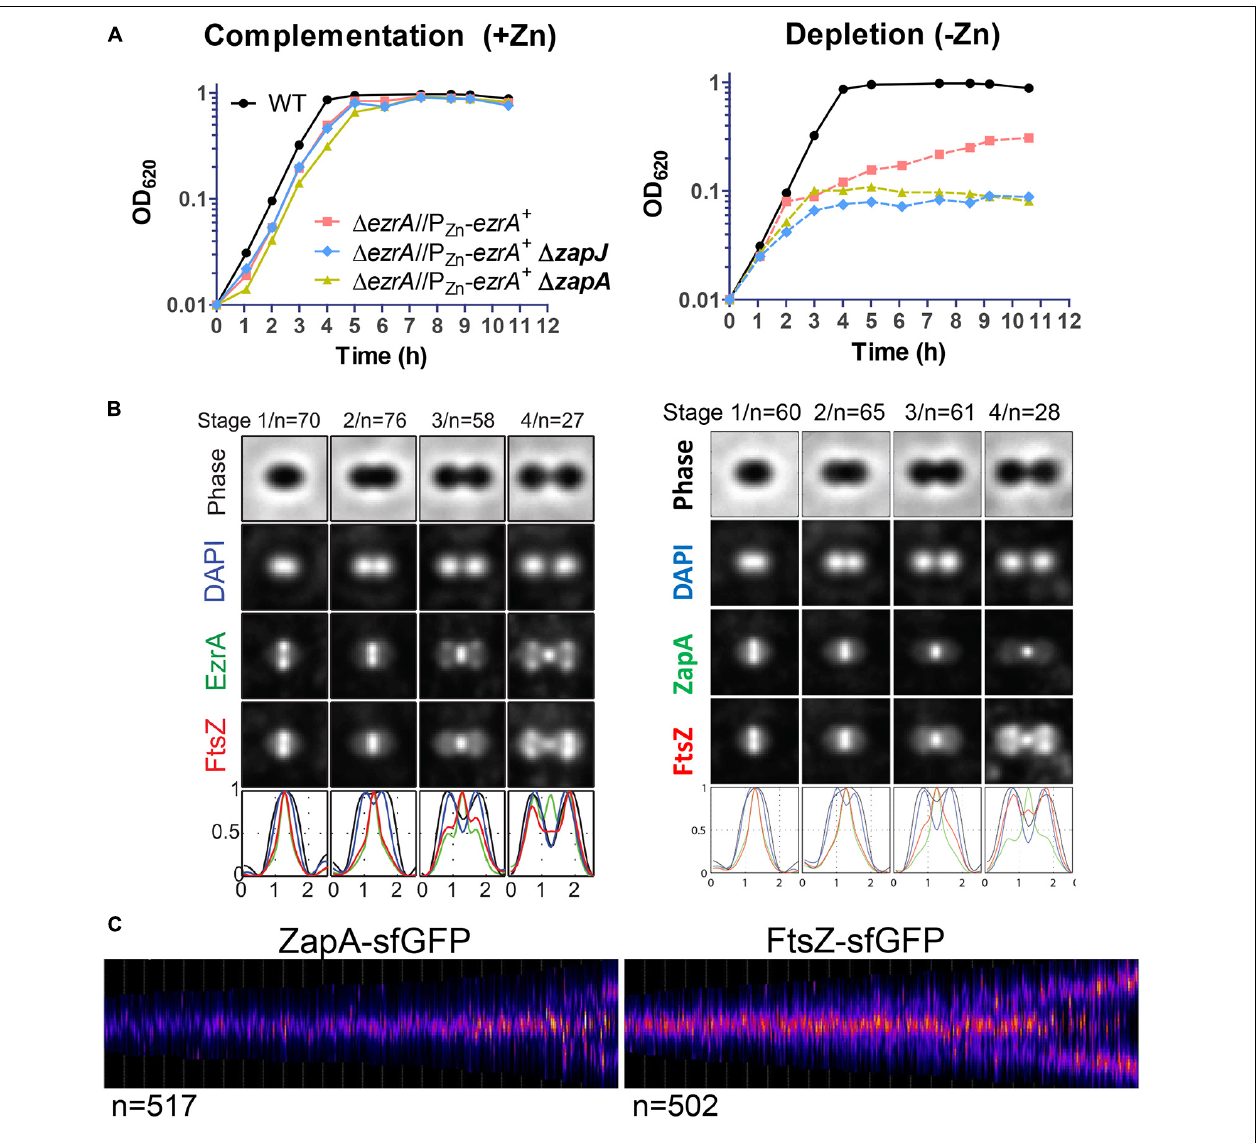
FIGURE 10 | Localization of ZapA relative to FtsZ and combined defects of (cid:49) zapA or (cid:49) zapJ with EzrA depletion in Spn . (A) Graph demonstrating the growth curve upon EzrA complementation (left graph) or EzrA depletion (right graph) in otherwise WT, (cid:49) zapA , or (cid:49) zapJ mutant backgrounds. Wild-type EzrA was induced by supplementation of 0.5 mM ZnCl 2 and 0.05 mM MnSO 4 or depleted by growth in the absence of supplemented Zn/Mn. Strains used were IU1945, IU8799, IU10839, and IU15029. (B) Averaged images with fluorescence intensity traces showing FtsZ and EzrA localization from IFM performed on IU8681 (left) or IU10752 (right). Cells were binned into division stages 1-4, and images from the indicated number of cells ( n ) from at least two independent biological replicates were averaged using the IMA-GUI program as described in section “Materials and Methods” and previously (Tsui et al., 2014). (i) Row 1, cell shapes determined from phase-contrast images; row 2, nucleoid locations from DAPI labeling; row 3, EzrA (left panel) or ZapA (right panel) locations from IFM; row 4, FtsZ locations from IFM; row 5, normalized mean fluorescence intensity distributions along the horizontal cell axis for each channel (black, phase image; blue, DNA; green, EzrA or ZapA; red, FtsZ). Cells from at least two independent biological replicates were collected at OD 620 ≈ 0.1–0.2 and prepared for each set of cells as described in section “Materials and Methods.” (C) Demographs of ZapA-sfGFP localization from strain IU10065 compared to FtsZ-sfGFP localization from strain IU9985 obtained using snapshot 2D-EFm of live cells. The indicated number of cells ( n ) from at least two independent biological replicates were analyzed using MicrobeJ and as described in section “Materials and Methods” and previously (Perez et al.,